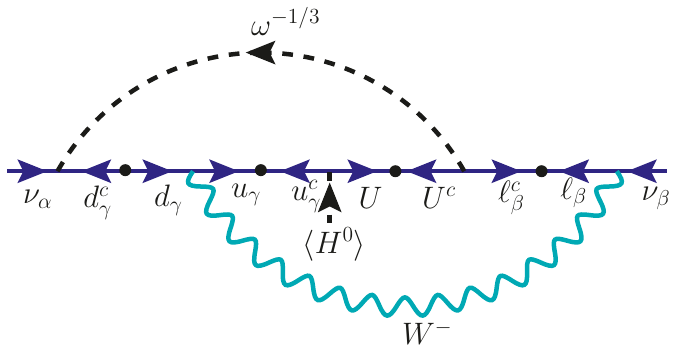
Figure 50 . Two-loop neutrino mass generation with SU(2) L -doublet LQ and SU(2) L -doublet vectorlike quark corresponding to